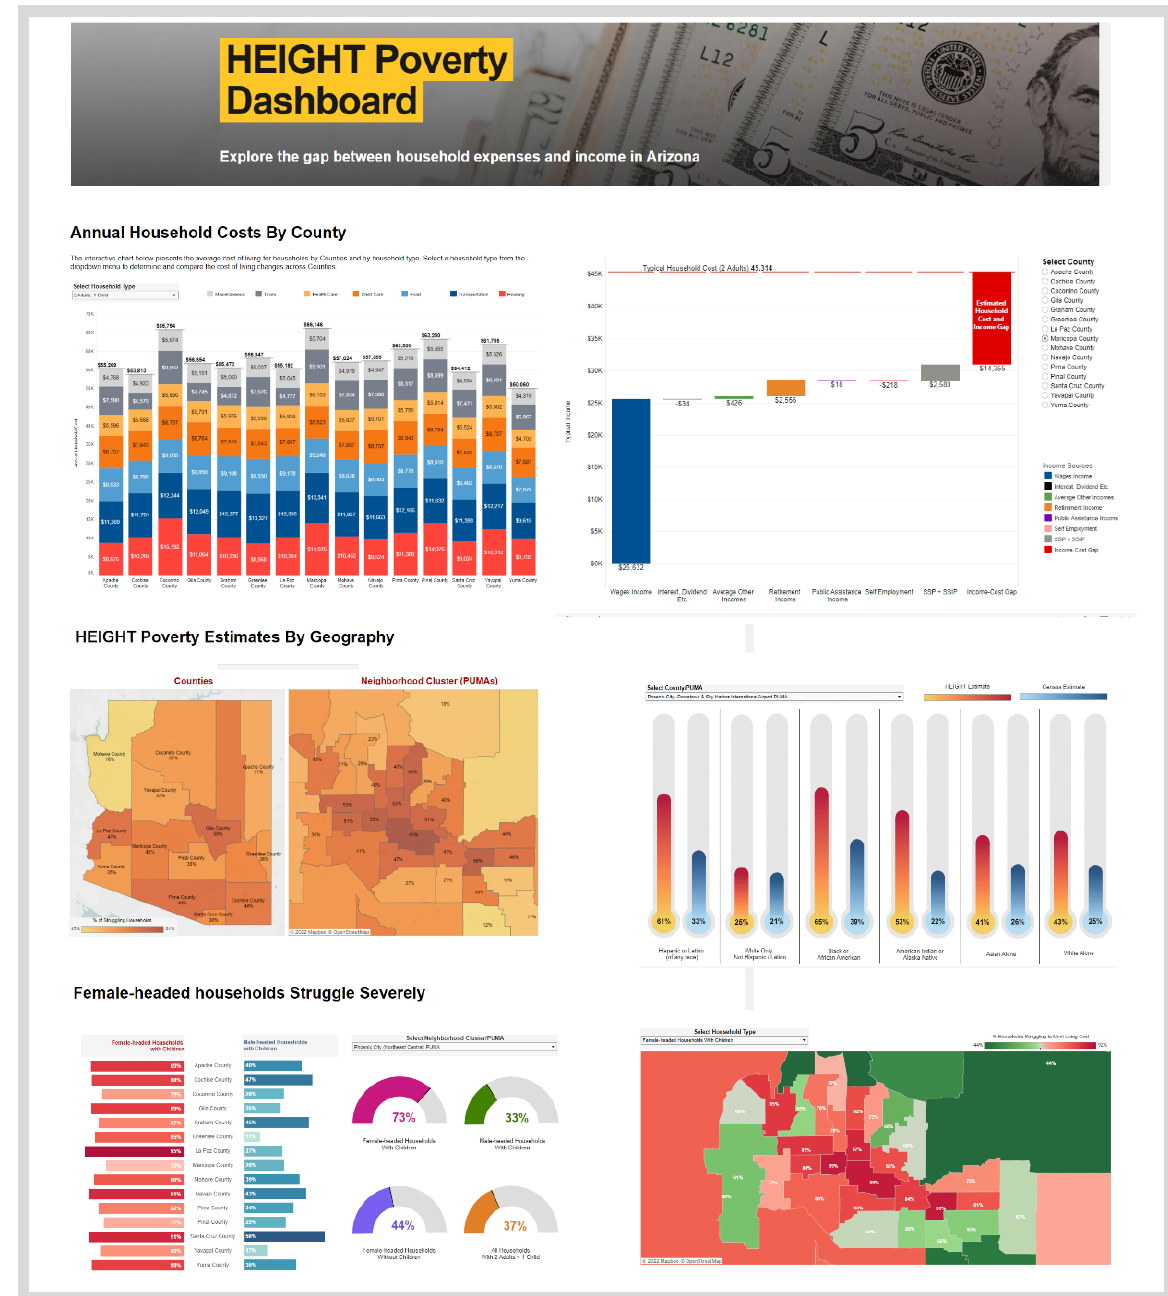
Figure 4. Overview of the HEIGHT Poverty Dashboard (Source: https://resilience.asu.edu/HEIGHT-poverty-dashboard )